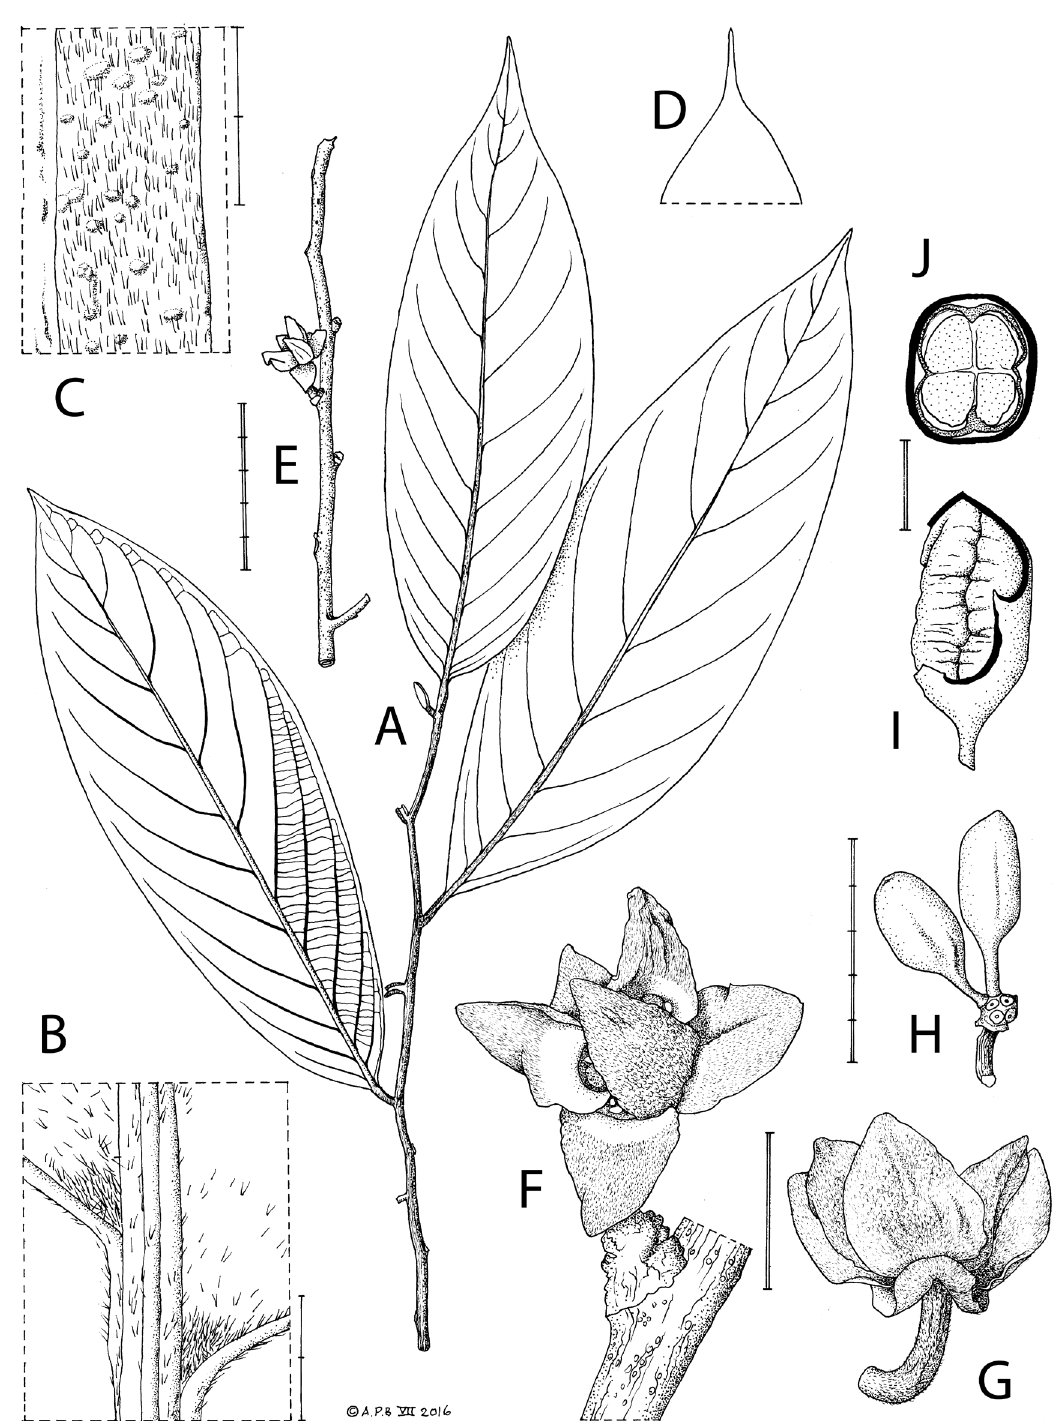
Fig. 3. Monoon salomonicum I.M. Turner & Utteridge sp. nov. A . Leafy twig. B . Domatia in axils of secondary nerves on leaf abaxial surface. C . Indumentum on adaxial surface of midrib. D . Example of more distinctly acuminate leaf apex. E . Branchlet bearing flower. F , G . Two views of flower, one attached, one detached. H . Fruiting pedicel bearing two monocarps. I . Monocarp with part of pericarp removed to expose seed. J . Transverse section of monocarp. Scale bars: graduated single bar = 2 mm; double bar = 1 cm; graduated double bar = 5 cm. Drawn from BSIP 3661 (A, C, E–J); RSS 2530 (B, D). Drawn by Andrew